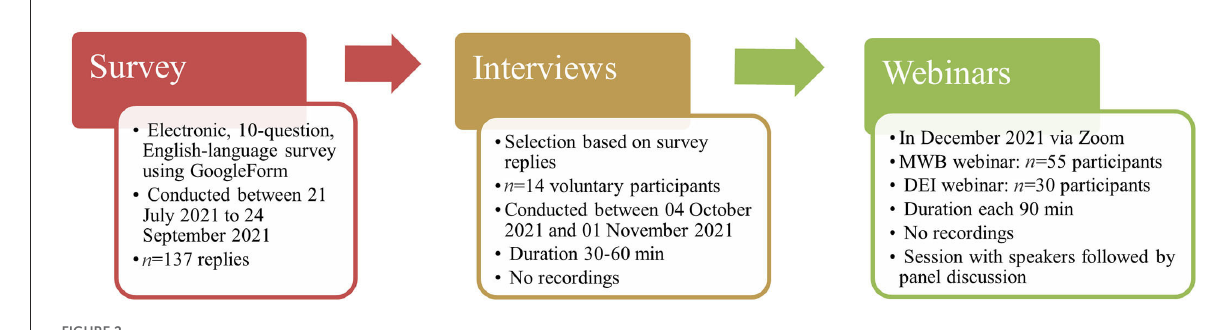
FIGURE2 Timeline and participants of the three stages of the mixed-method